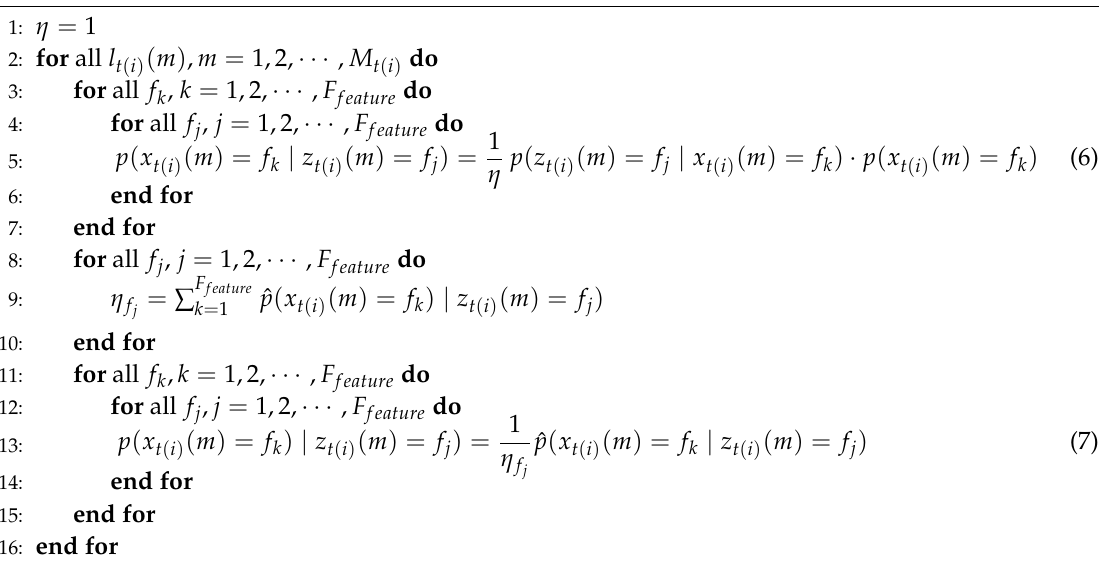
Algorithm 2 Application of measurement